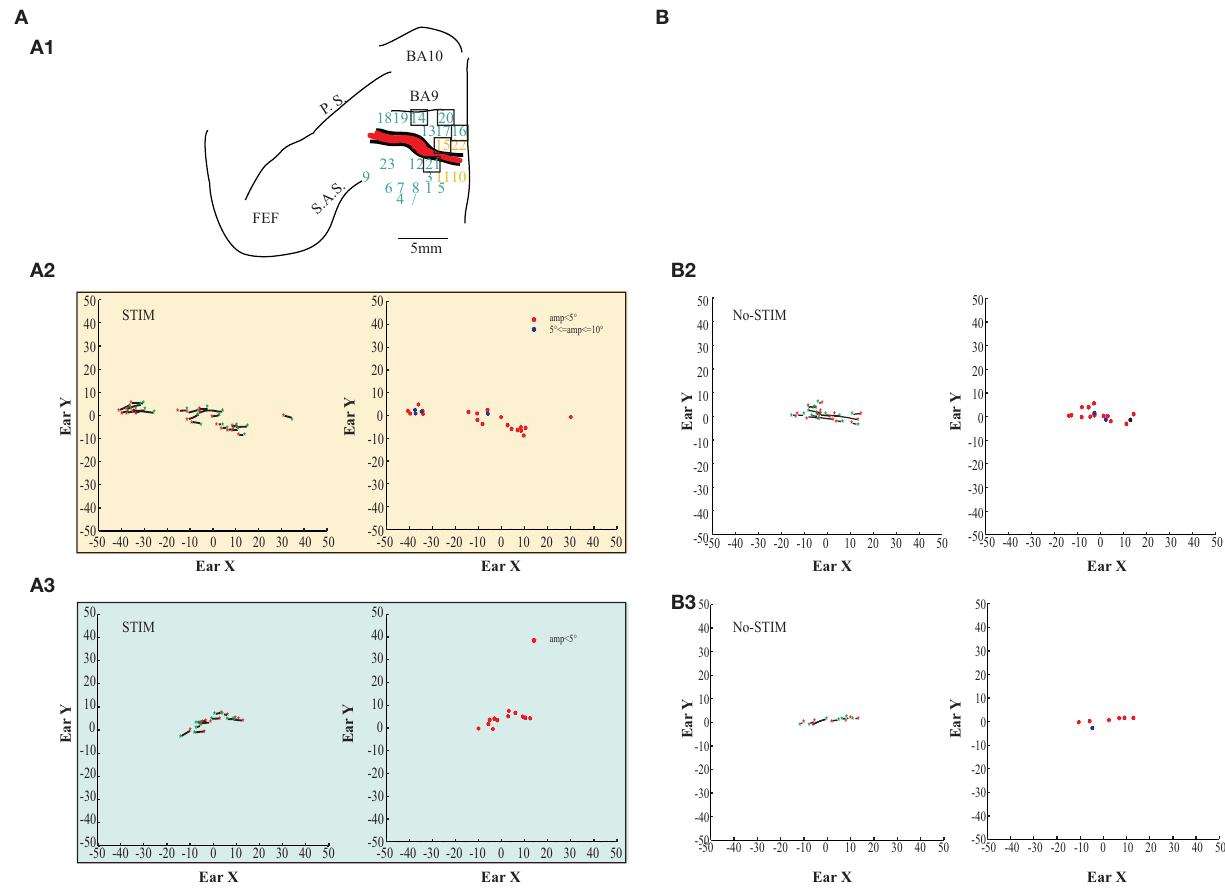
FIGURE 4 | Example of fixed-vector ear movements. (A) The figures show data from monkey L. (A1) Map shows the locations of the electrode penetrations; numbers in the black squares indicate the penetrations where fixed-vectors were evoked; yellow numbers represent penetrations of the core region, while aquamarine numbers represent penetrations of the belt region. Red thick line represents a superficial vessel which was avoided during the experimental sessions. FEF: Frontal Eye Field; SAS: Superior Arcuate Sulcus; PS: Principalis Sulcus; BA9: Brodmann Area 9; BA10: Brodmann Area 10. (A2) Example of fixed-vector forward ear movements in the core region; red ∗ : starting position; green ∗ : ending position. The plot on the left shows the direction of the ear movements. The plot on the right